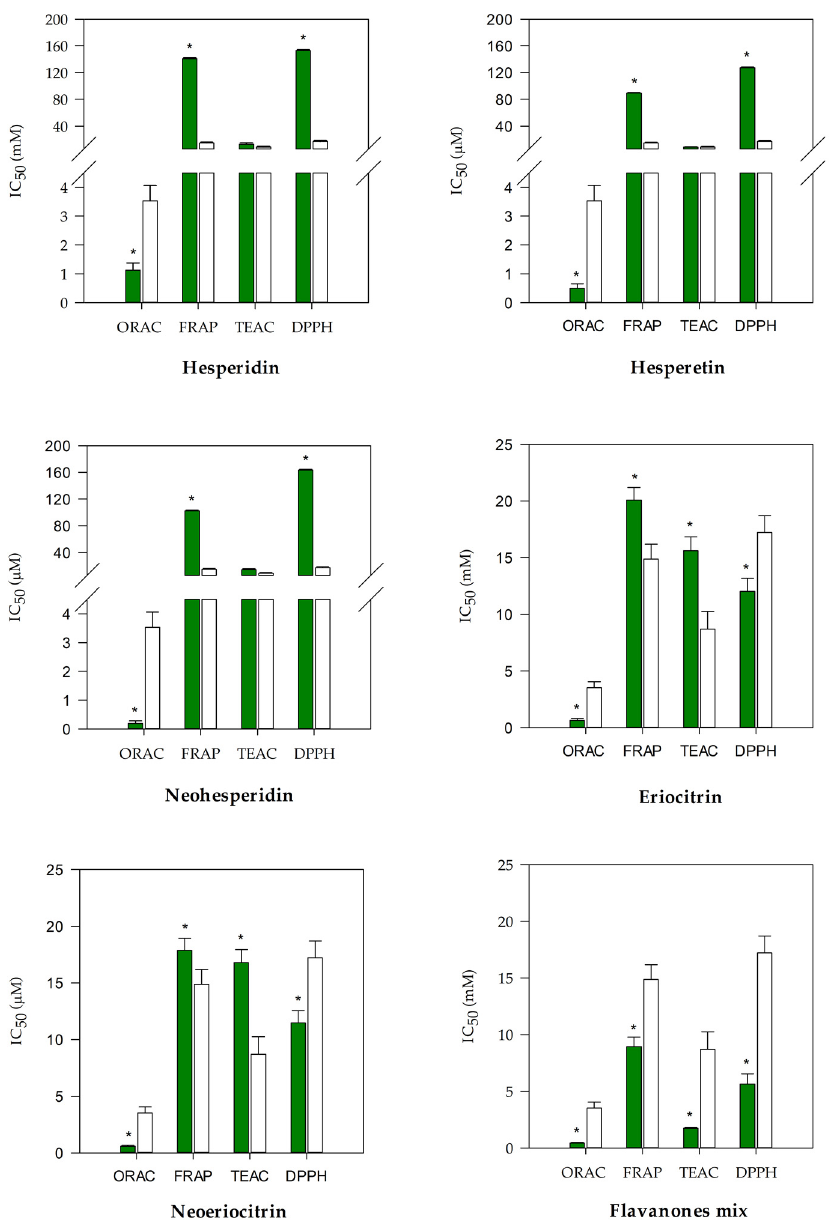
Figure 2. Antioxidant and free radical-scavenging activity of Citrus flavanones ( green bars ) in comparison with the reference compound trolox ( white bars ). Results were expressed as mean half- maximal inhibitory concentration (IC 50 , µM) ± S.D. of three independent experiments in triplicate ( n = 3); * p < 0.001 vs. trolox.